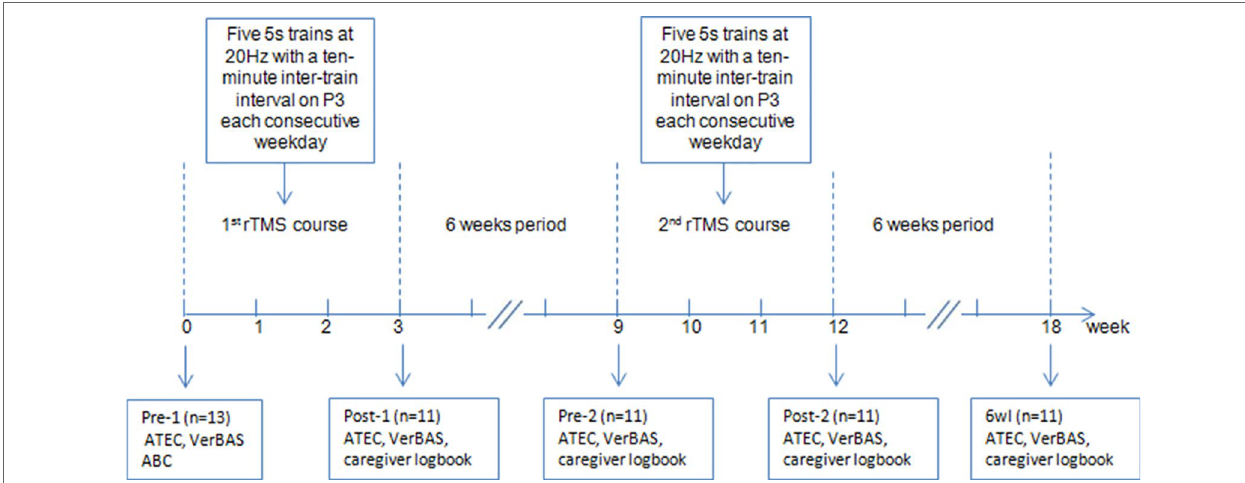
FIGURE 1 | Flow diagram of the experiment. Note: ATEC, Autism Treatment Evaluation Checklist; VerBAS, Verbal Behavior Assessment Scale; ABC, Autism Behavior Checklist; P3, left parietal electrode.